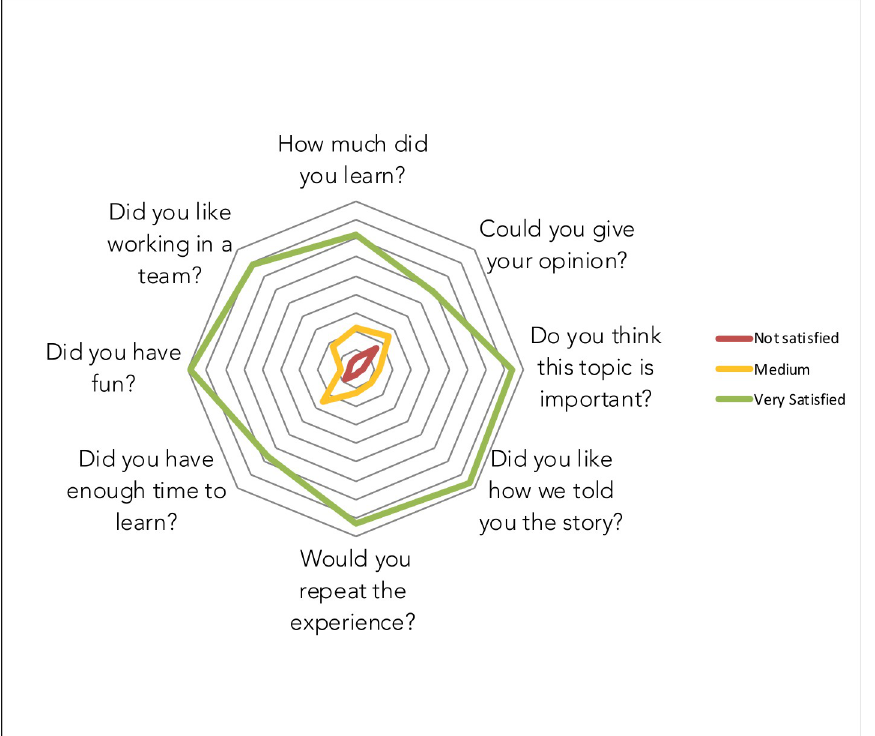
Fig 5. Children’s feedback through answering eight questions about our performance, n = 224.